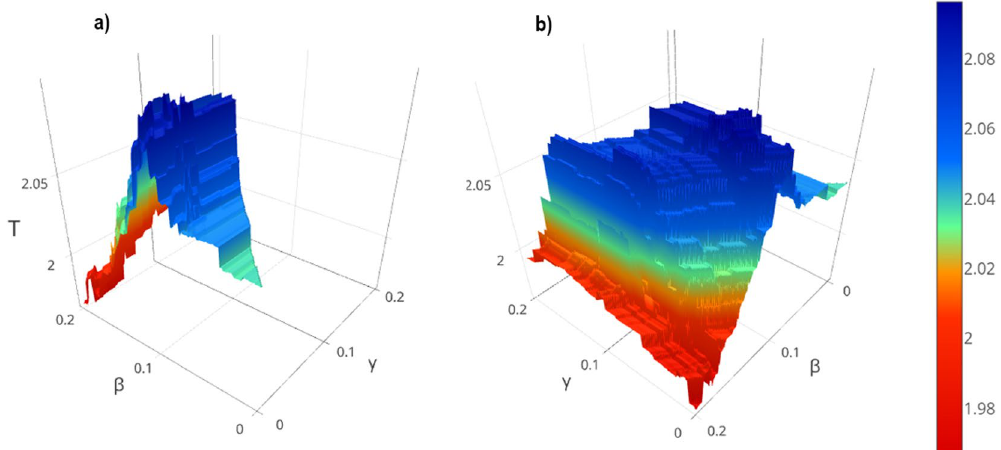
Figure 1. Performance of IMHRC for the different values of β and γ on the Collins dataset and the SGD gold standard. The β and γ axes indicate the number of hubs that have been removed and put back, respectively and T axis specifies the performance of method. ( a ) The back view of surface is shown in this figure. ( b ) The front view of surface is shown in this figure.